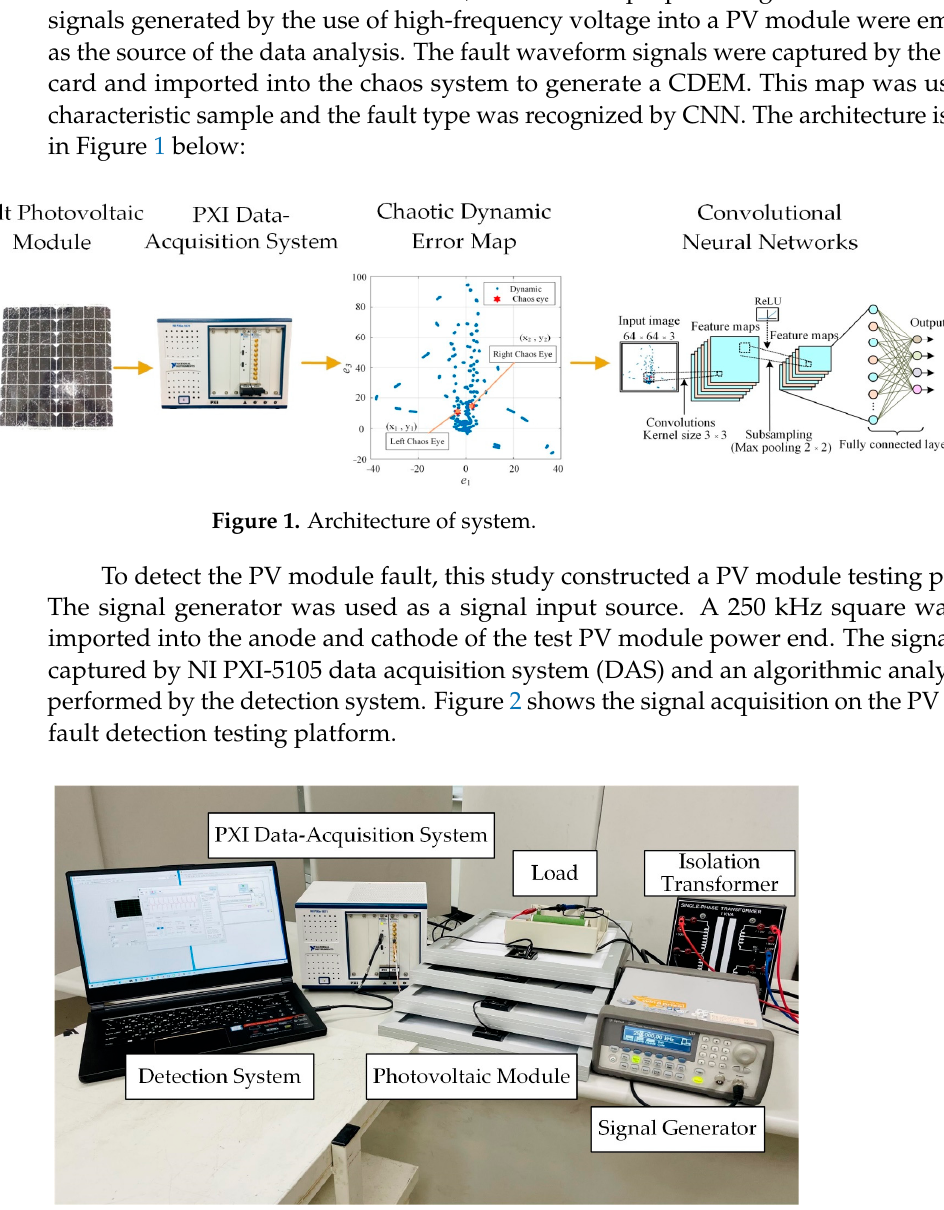
Figure 2. PV module fault detection testing platform.